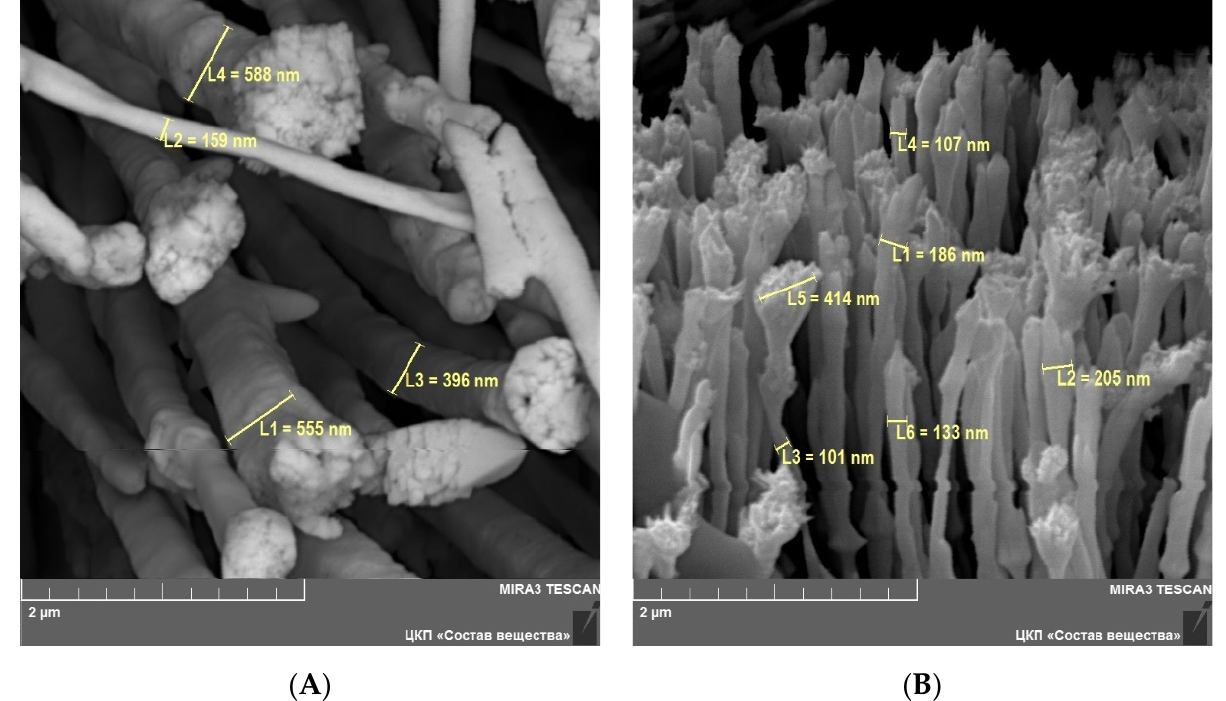
Figure 8. SEM images of rhenium nanofibers obtained at the potentials of 400 mV ( A ) and at the potentials of 690 mV ( B ).